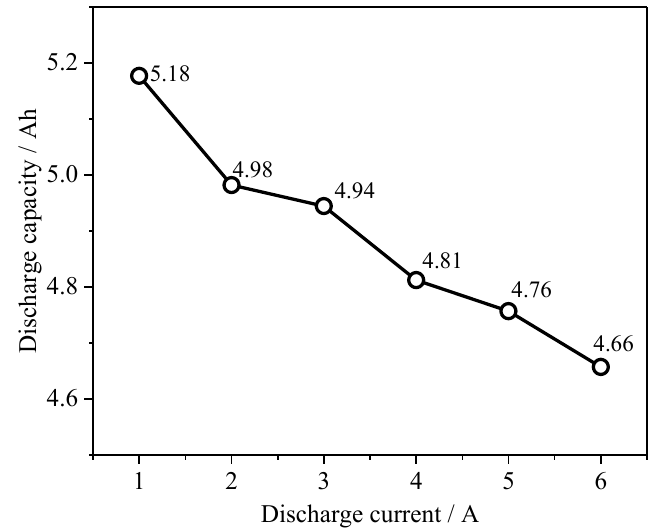
Figure 6. Effect of operating current on discharge capacity.